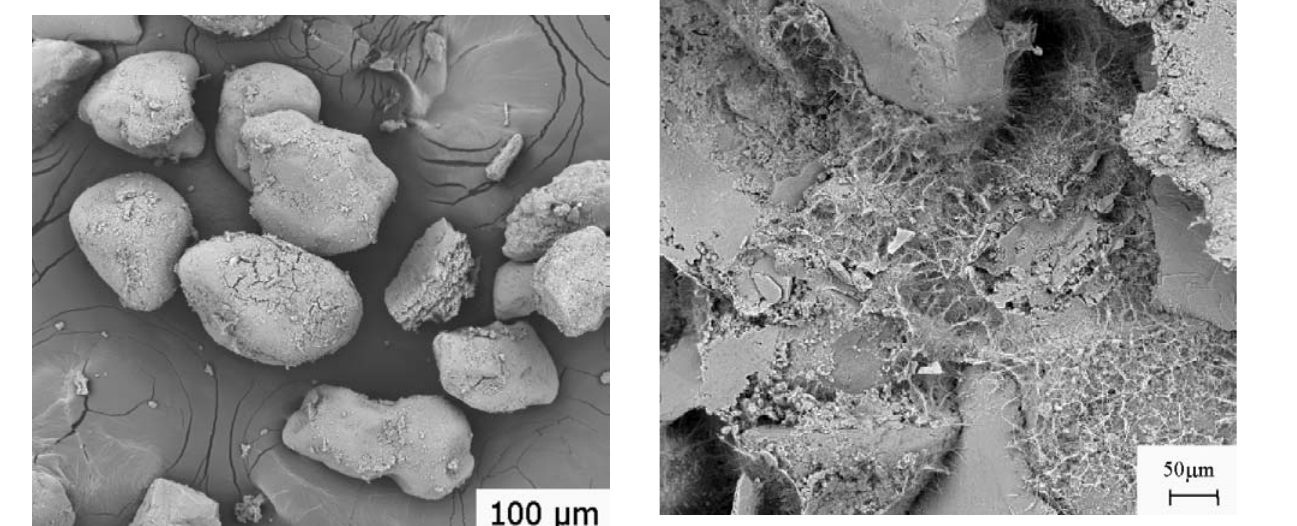
Figure 7. SEM micrograph showing gel crystallization on the (Rs) Matrix (CPI-S-32 cement/sand) after 28 days of